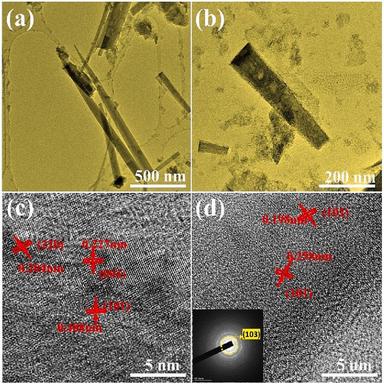
(a, b) TEM images of Ni-Co/CoMn2O4 nanomaterials composite. (c, d) HRTEM images of CoMn2O4 nanowires and Ni-Co nanomaterials.